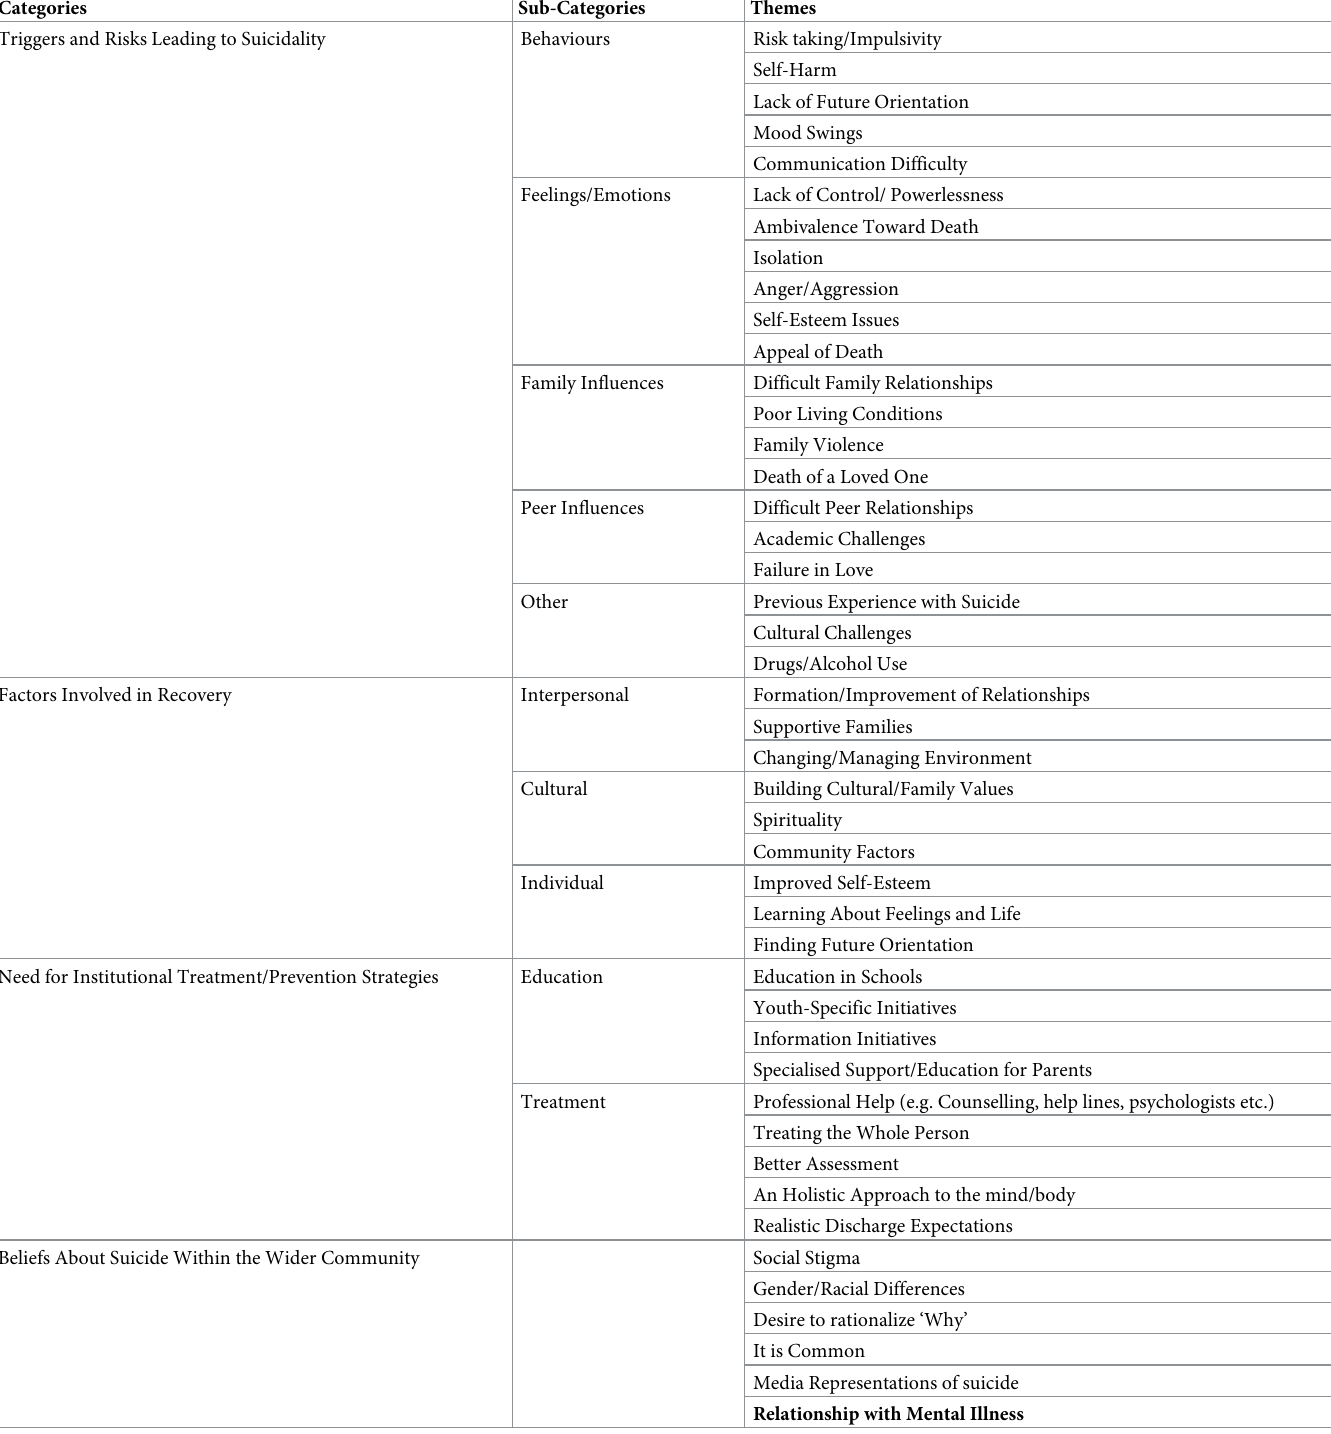
Table 6. Summary of key